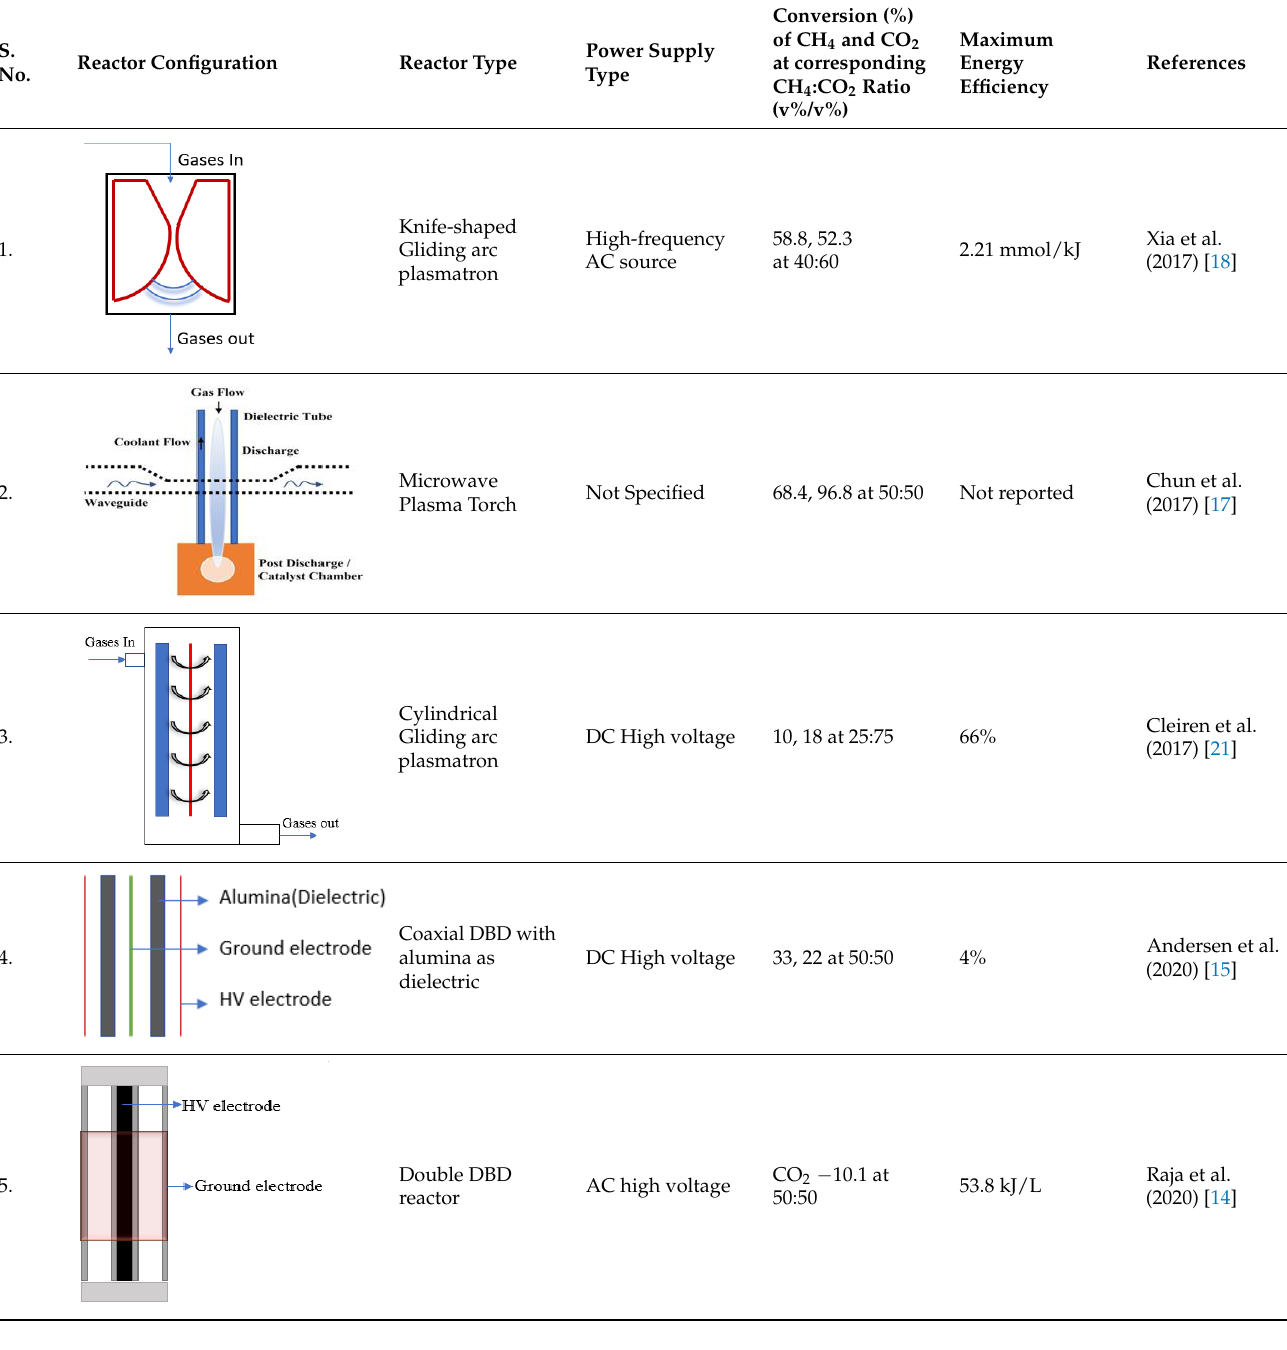
Table 1. Reactor configurations reported for DRM and the corresponding conversion and energy efficiencies. S. No.